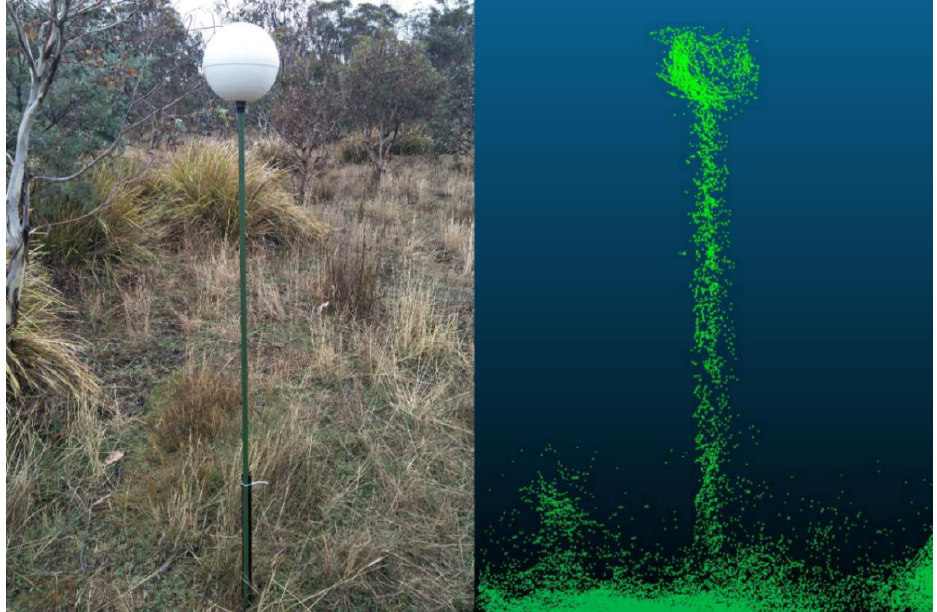
Figure 2. Reference target on top of its support used in the field ( left ) and its captured 3D point cloud ( right ).